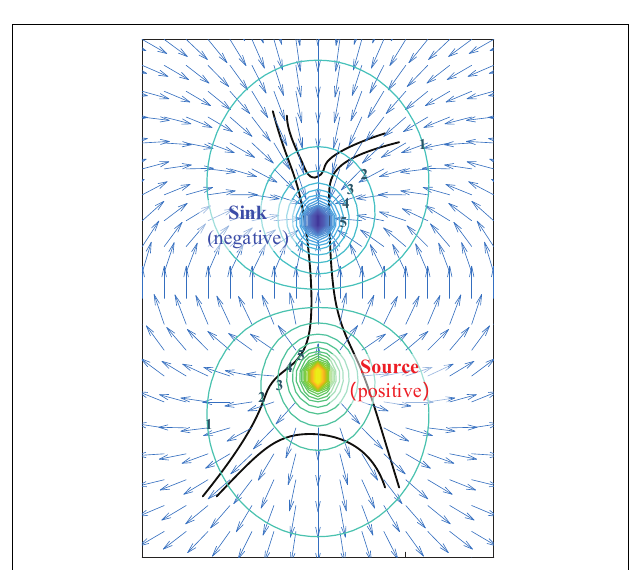
FIGURE 5 | A simplified dipole model for generating the extracellular electric field.